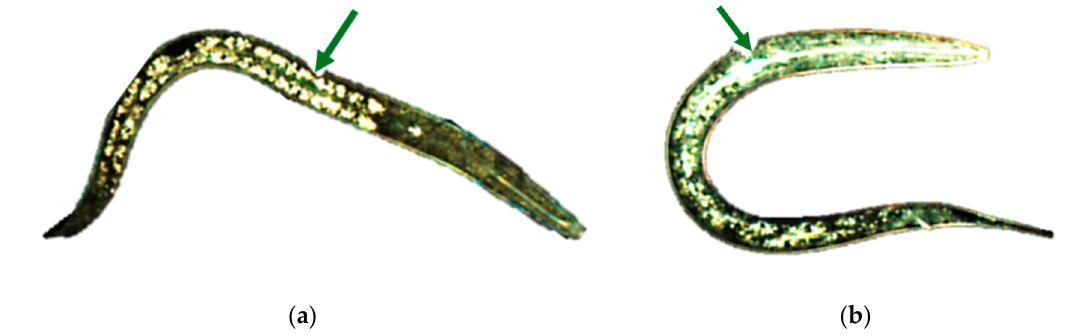
Figure 30. Representative dark field image of ( a ) control wild-type nematode (green arrow indicates the light scattered by tissue aggregates from nematode extraintestinal tissues) and of ( b ) a wild-type nematode exposed to 12.5 mg / L CeO2 NPs for 24 h (green arrow indicates ingested CeO2 NPs). (Modified after [144]).